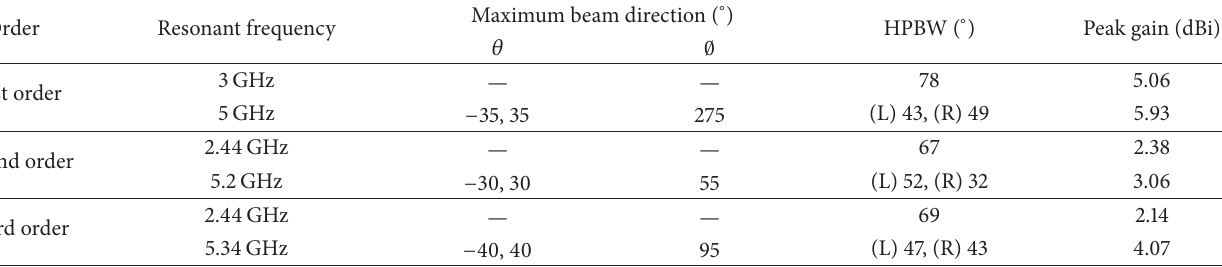
Table 3: Summary of the measured antennas’ performances.